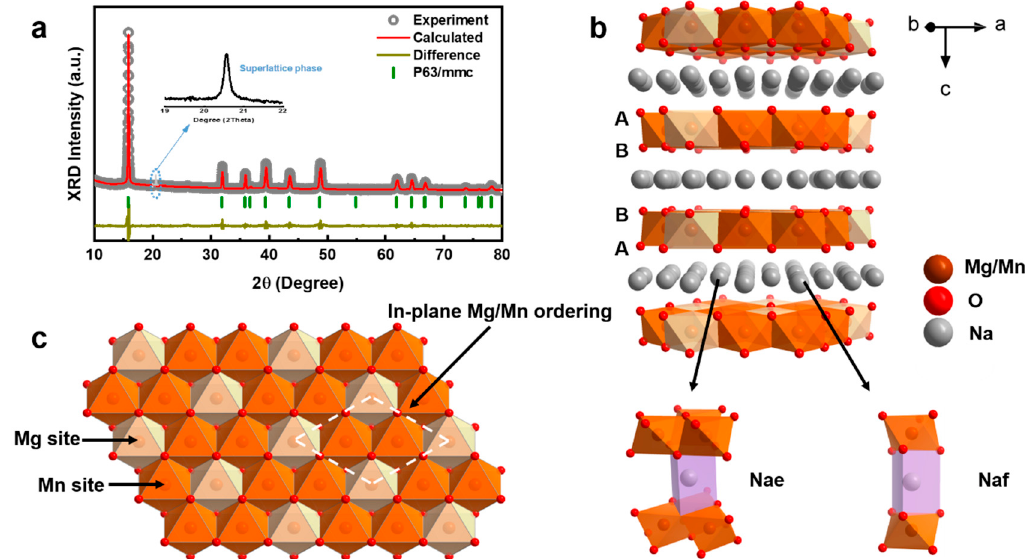
Figure 1. ( a ) XRD patterns and Rietveld refinement curves of NaMMO. The insert shows the enlarged view at 2 θ between 19°–22°. ( b ) Schematic diagram of the crystal structure. ( c ) Mg 2+ /Mn 4+ cationic honeycomb ordering in the TM layers, viewed along the z directions.